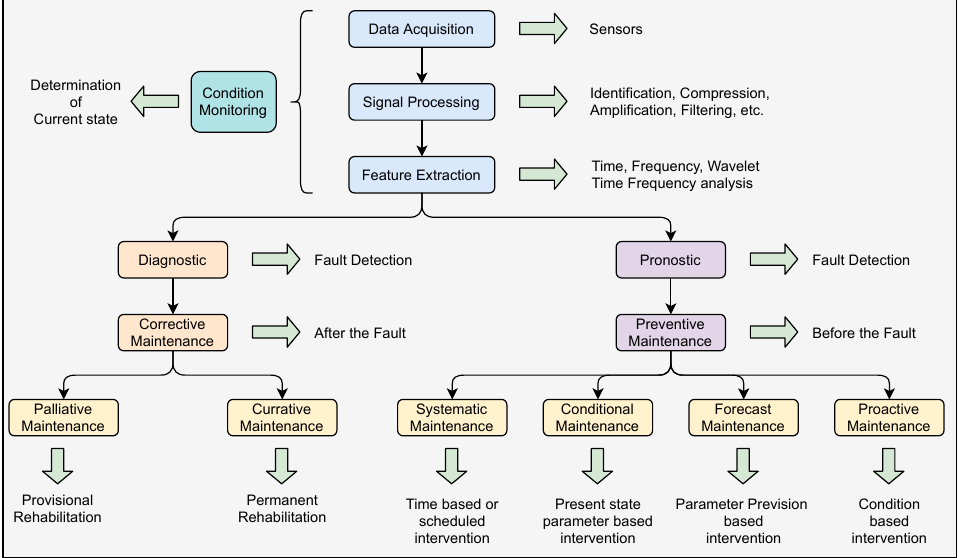
Figure 2. Overview of condition-monitoring and maintenance processes for WTs